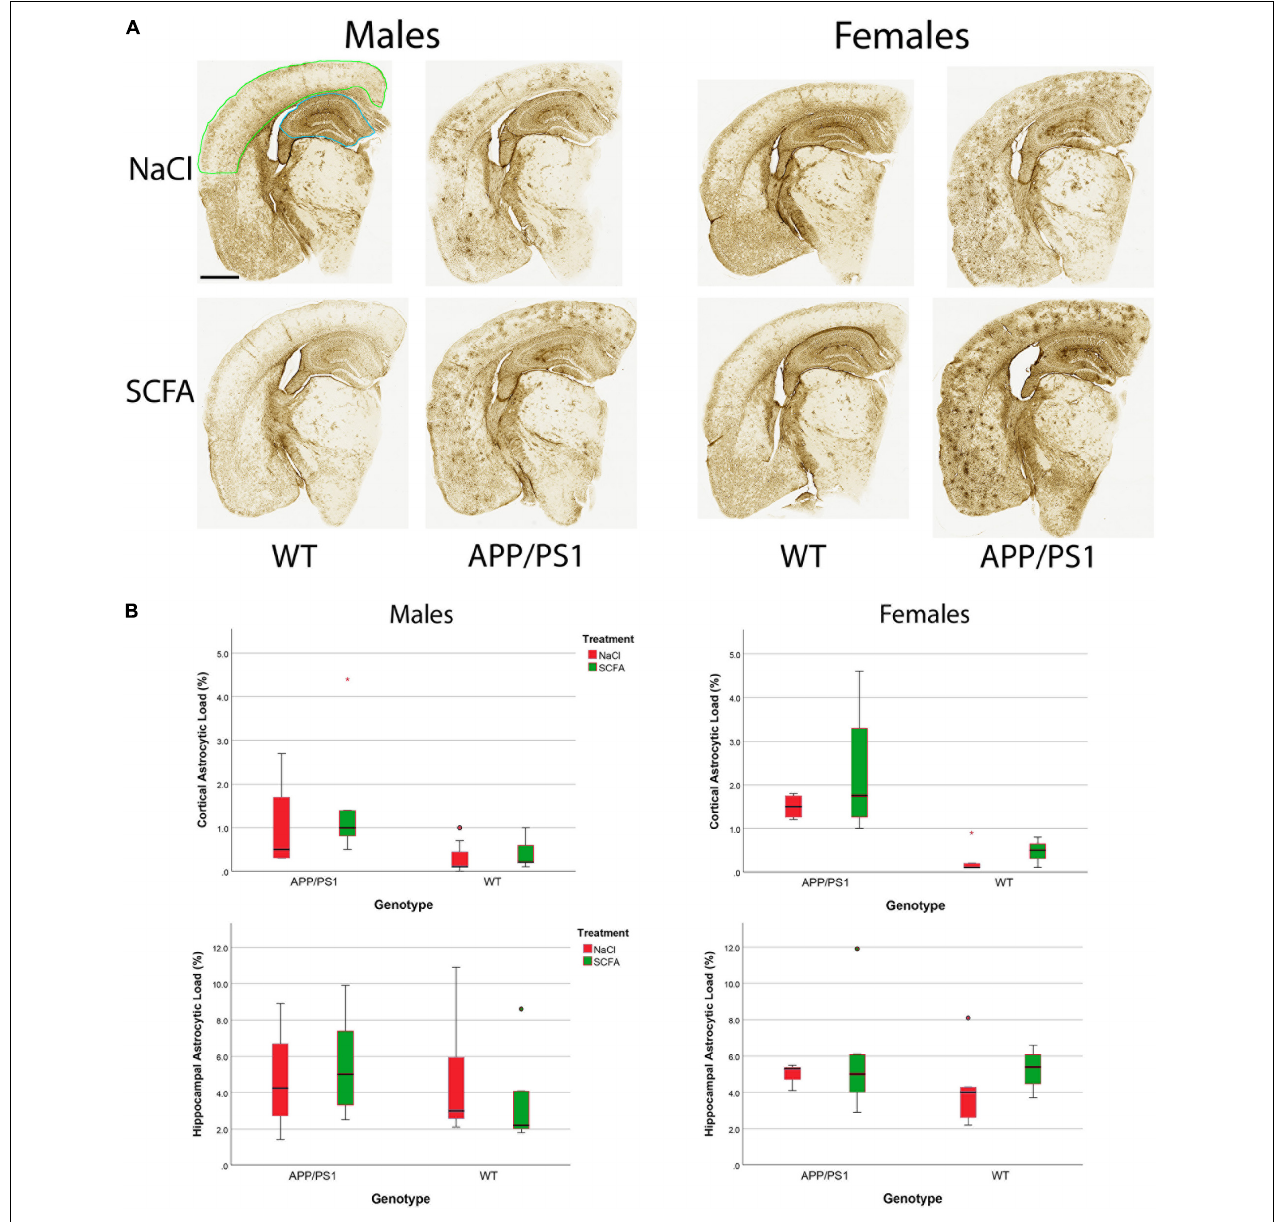
FIGURE 7 | Gfap staining and quantification indicate short chain fatty acids (SCFA) has no effect although labeling is increased in cortices of APP/PS1 mice. Gfap expression was detected by Gfap immunohistochemistry (A) . Scale bar represents 1 mm. Green outlining indicates the typical ROI for cortical staining while blue outlining indicates the ROI for hippocampal staining. Statistical analysis confirms a significant difference with APP/PS1 transgenes but not SCFA treatment in the cortex (B) . Staining was quantified using HALO Area Quantification v.2.2.1. Statistical significance was determined by using a general linear model. Datapoints marked as circles represent ourliers (3rd quartile + 1.5 × interquartile range) while asterisks mark extreme outliers (3rd quartile + 3 × interquartile